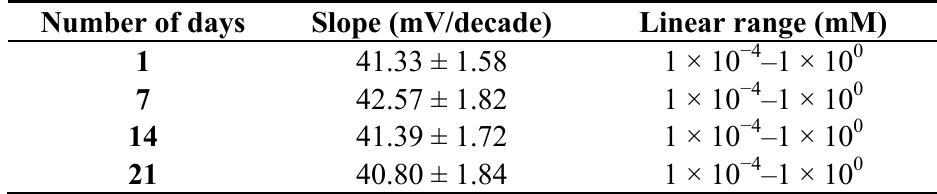
Table 2. The life time of electrode.